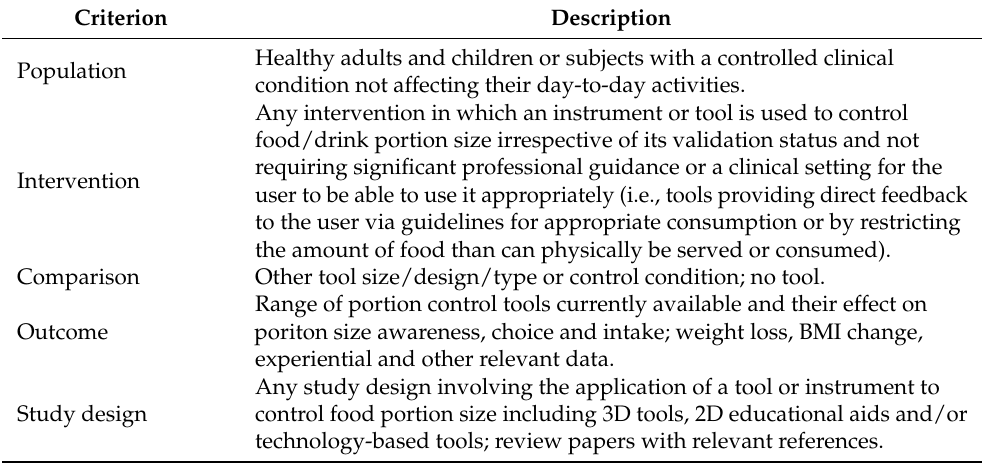
Table 1. PICOS criteria for inclusion and exclusion of studies (based on